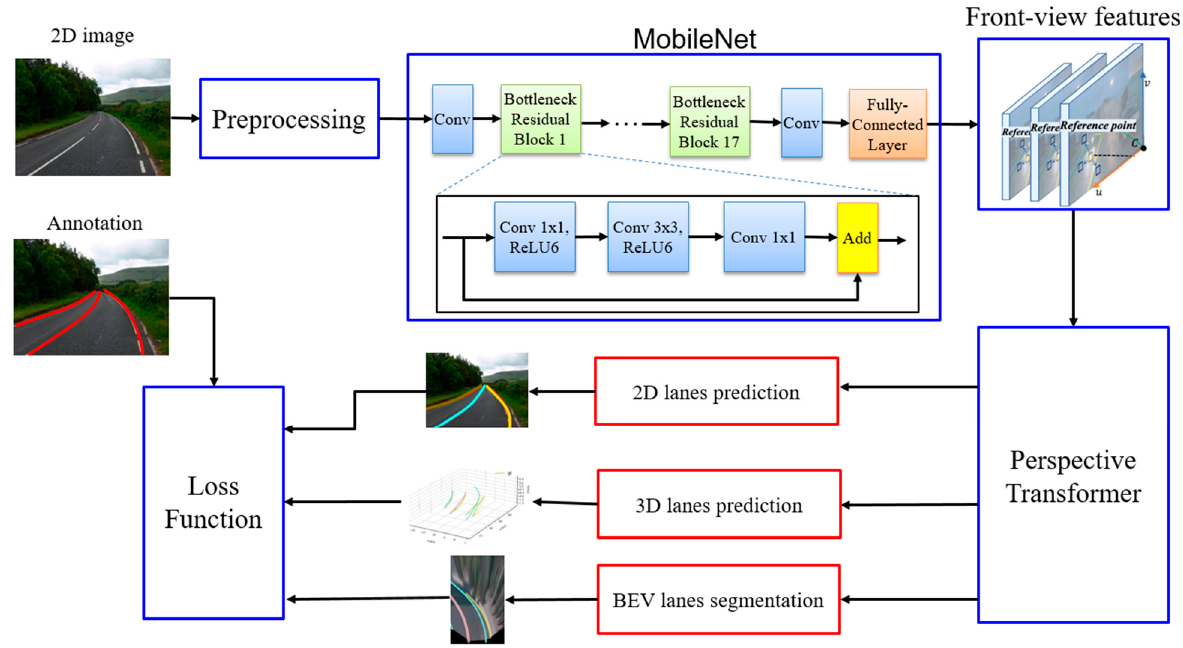
Figure 1. Proposed method for 3D lane detection.